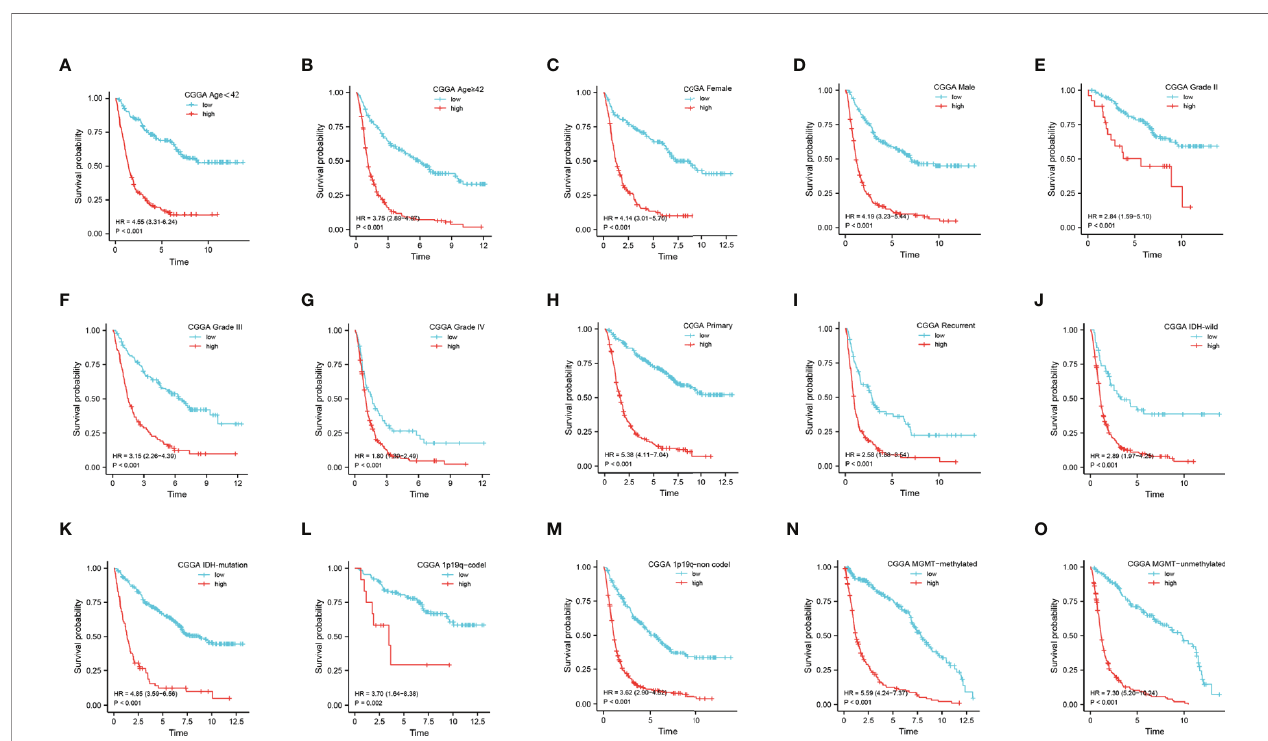
FIGURE 5 | Prediction of outcome of the DDRGs signature in strati fi ed patients in the CGGA dataset. (A – O) Survival analysis of the signature in patients strati fi ed by age, sex, PRS type, grade, IDH, 1p19q status, and MGMT promoter. CGGA, Chinese Glioma Genome Atlas; DDRG, DNA damage repair gene; IDH, isocitrate dehydrogenase; MGMT, O-6-methylguanine-DNA methyltransferase; PRS, primary-recurrent-secondary.